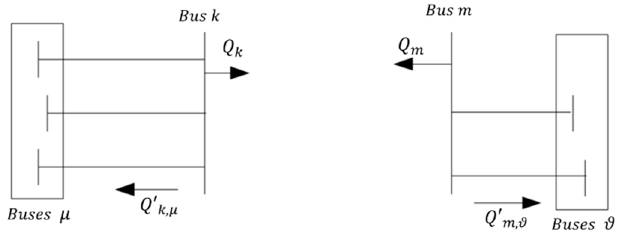
Figure 5. Post-switch state of the power system. Energies 2018 , 11 , x FOR PEER REVIEW